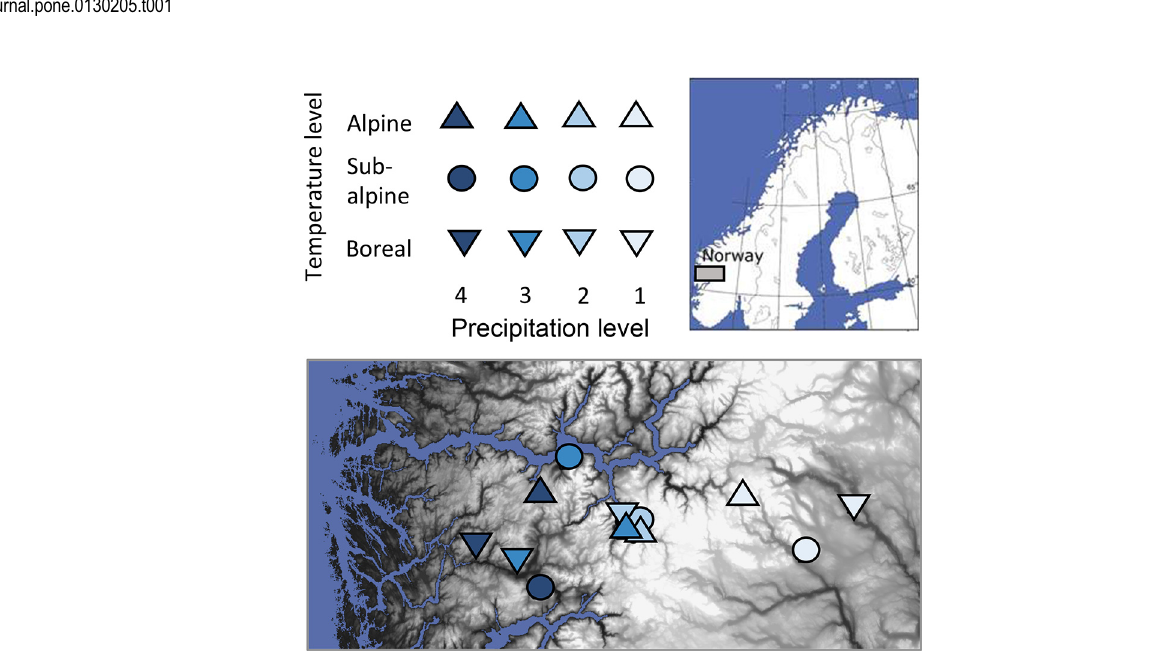
Fig 1. Map and study design. Location of the twelve study sites along temperature and precipitation gradients in the fjord landscape of southern